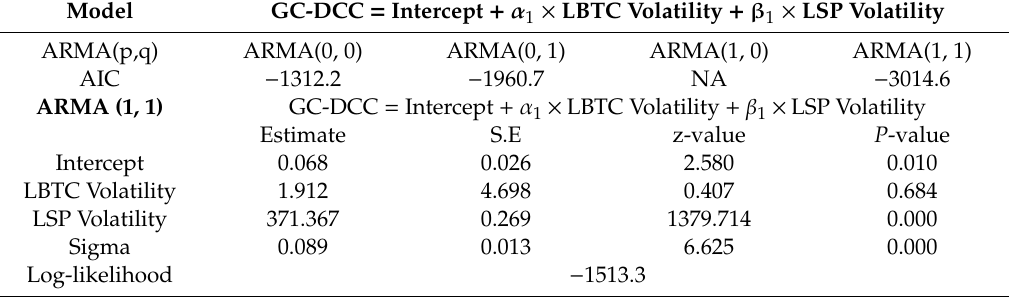
Table 12. Gaussian Copula Marginal Regression (GCMR) with standard-GARCH (1, 1) volatilities. Selection of p and q for ARMA based on AIC of 4 cases of (0, 0), (0, 1), (1, 0), and (1, 1). ARMA (0, 0) is selected based on AIC criteria. GCMR Model fit of GC-DCC with LBTC Volatility, and LSP Volatility of Error dependence structure ARMA (1, 1).